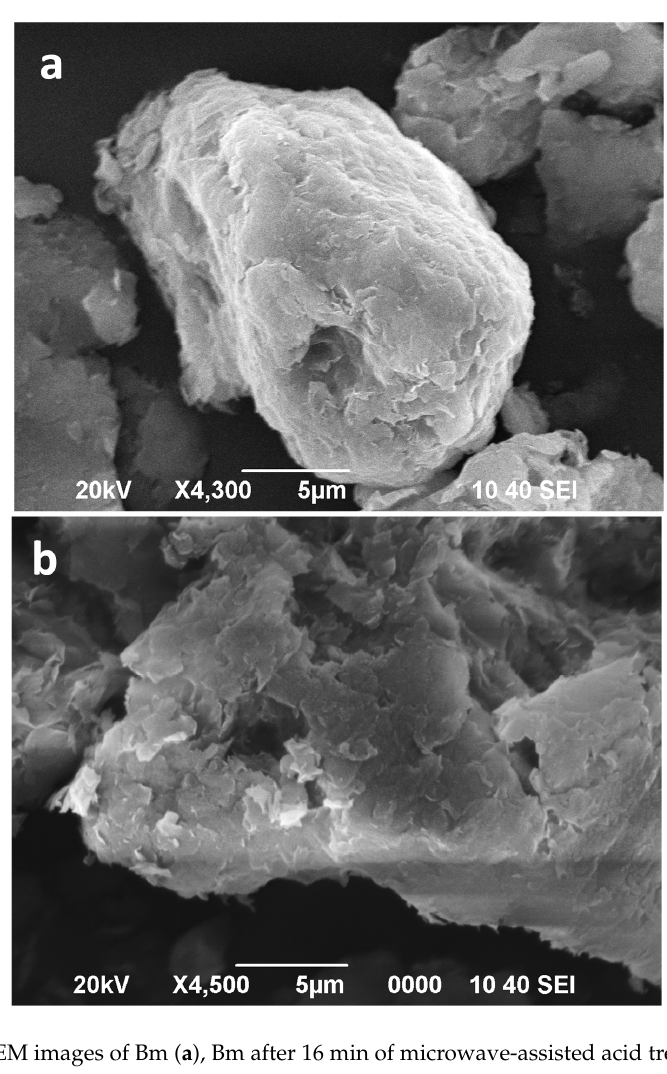
Figure 6. SEM images of Bm ( a ), Bm after 16 min of microwave-assisted acid treatment ( b ).